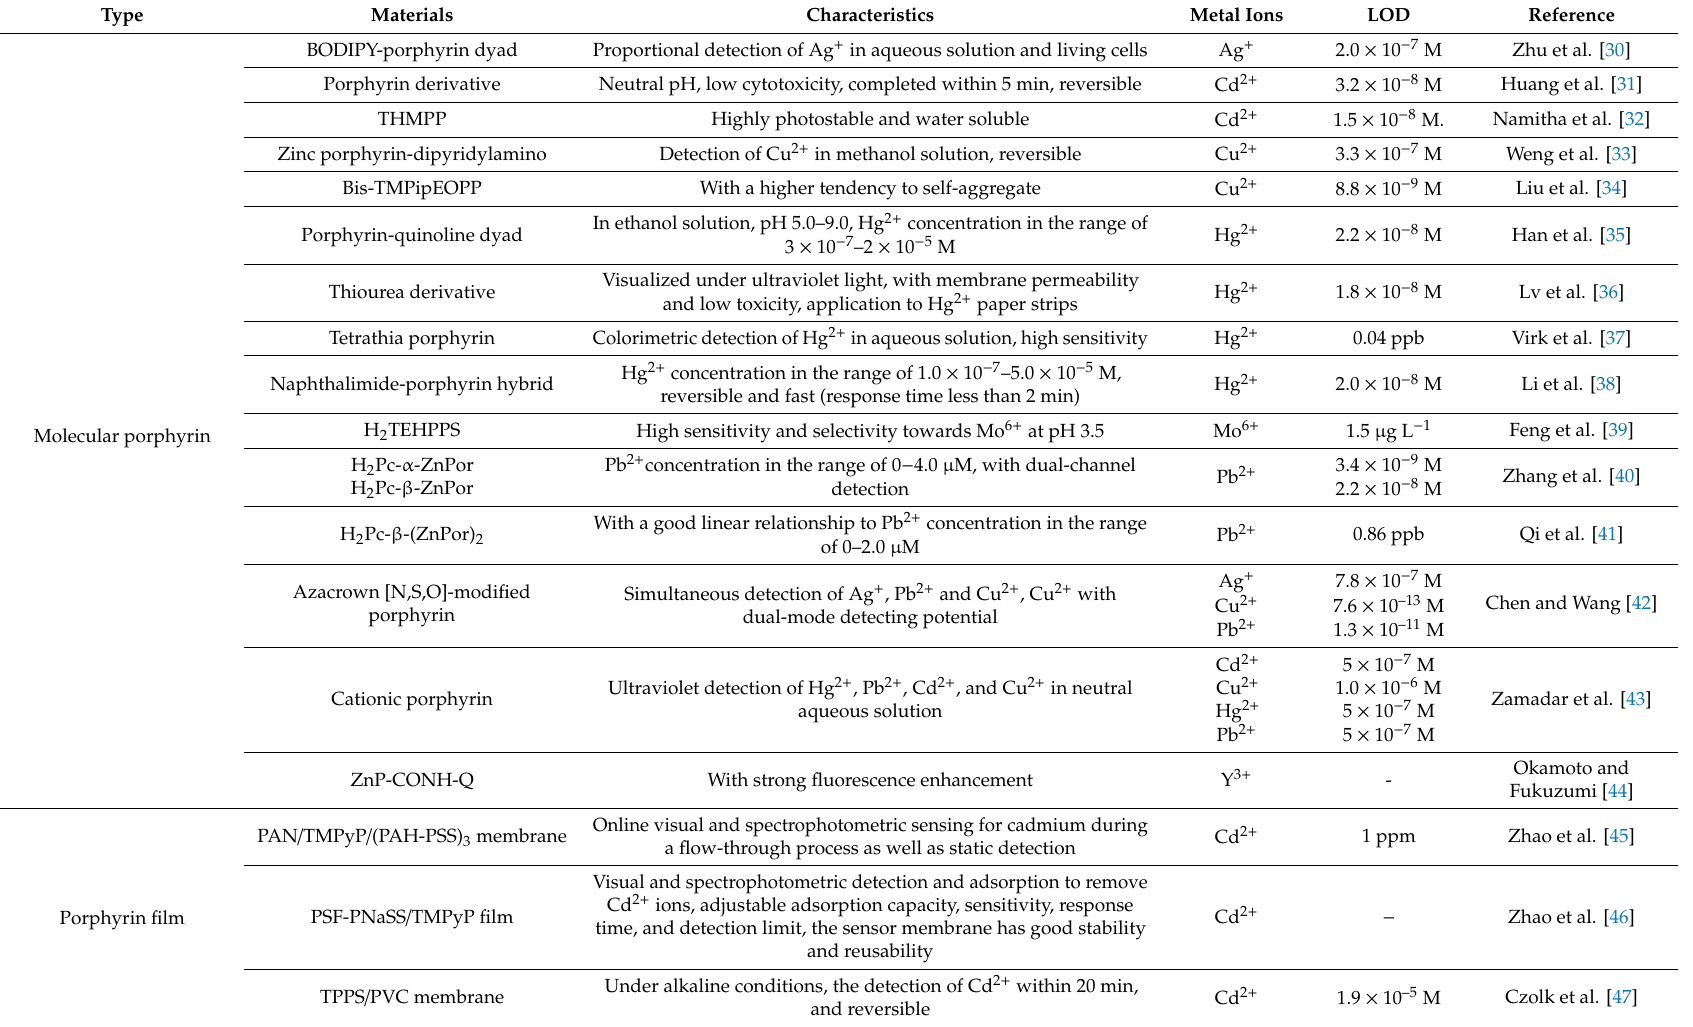
Table 1. Summarized porphyrins and porphyrin-based materials for metal ions